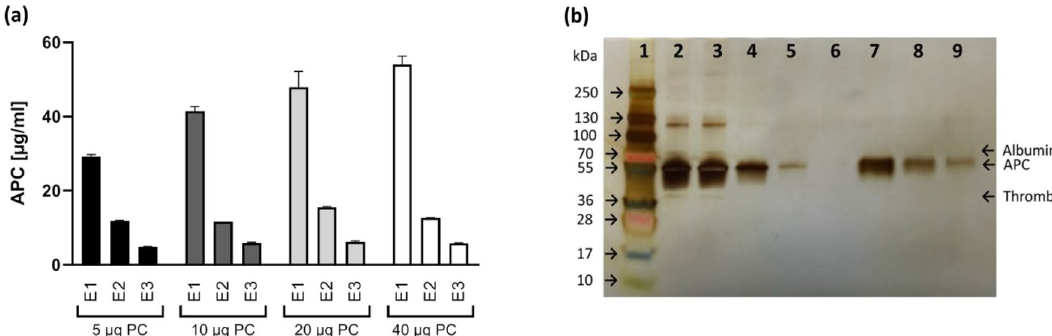
Figure 6. Evaluation of capture and elution process using PC. ( a ) APC generated by activation of different PC amounts was captured using HS02-52G coupled MyOne beads and eluted using elution buffer containing 5 mM EDTA. The APC content in each elution (E1 to E3) step was quantified using the APC activity assay and an APC standard curve. Data are shown as mean ± SD of three measurements. ( b ) The purity of the captured APC was analyzed qualitatively on SDS-PAGE gel. Samples from 10 µg PC starting solution before and after capturing, and corresponding samples of washing and elution fractions were loaded on SDS-PAGE gel and subjected to silver-staining. Lane 1, protein ladder; lane 2, supernatant before capturing; lane 3, supernatant after capturing; lane 4, first washing fraction; lane 5, second washing fraction; lane 6, third washing fraction; lane 7, first elution fraction; lane 8, second elution fraction; lane 9, third elution fraction.